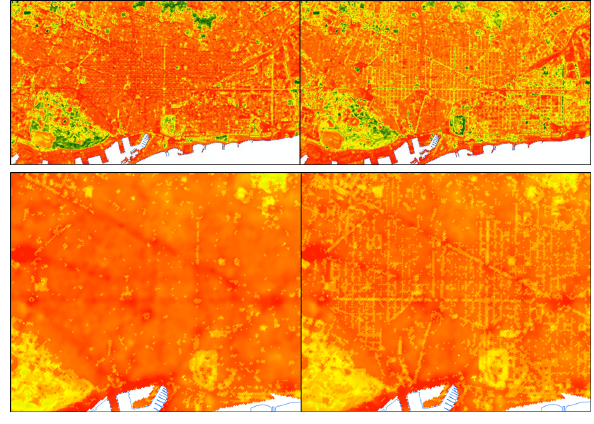
Figure 3. NDVI (winter/summer) 2015